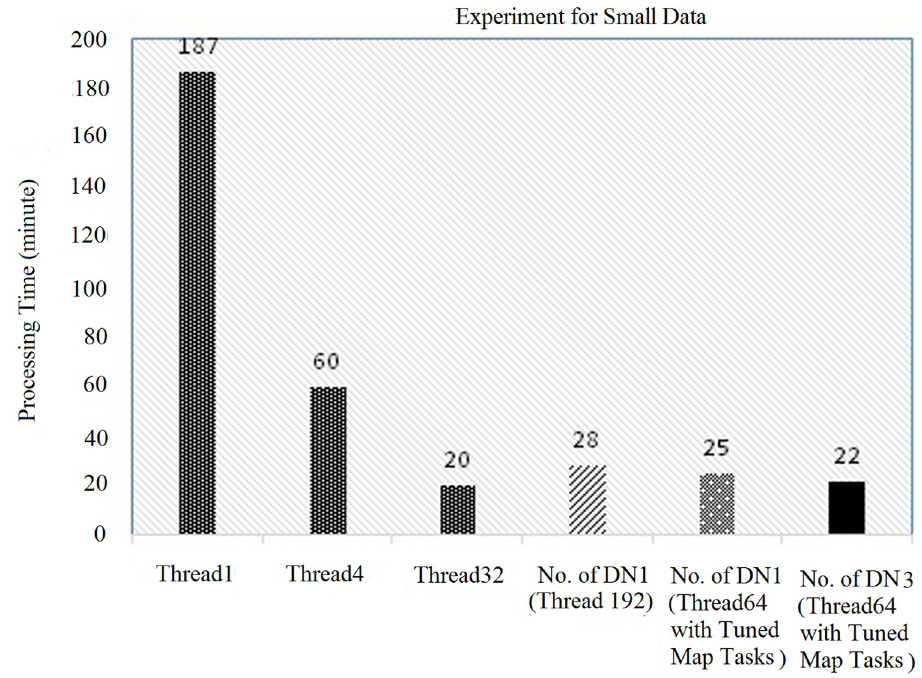
Fig 21. Experiment with tuned map tasks using single DataNode.